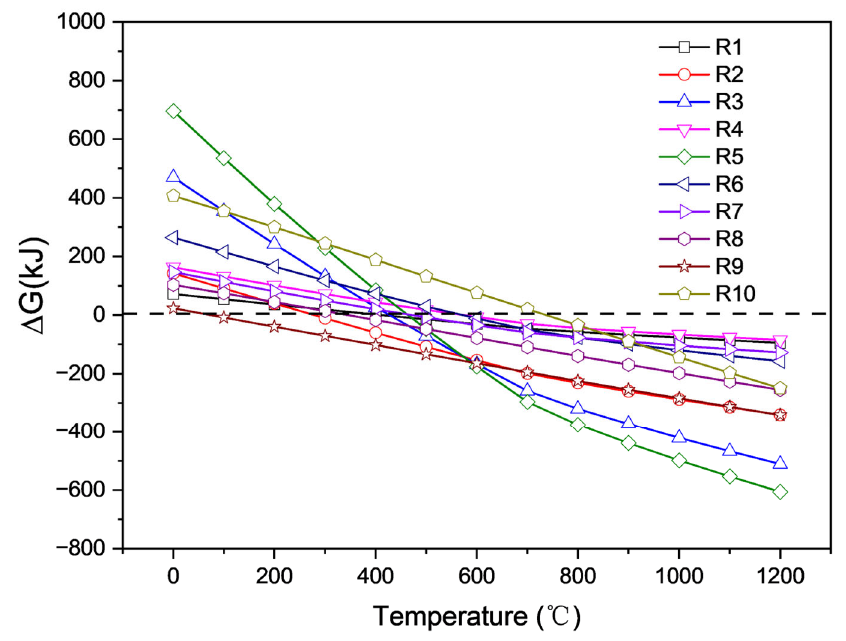
Figure 10. ∆ G of different possible reactions of lithium carbonate and cobalt tetroxide with main components of ceramics at different temperatures obtained by HSC chemistry 6.0 calculation.